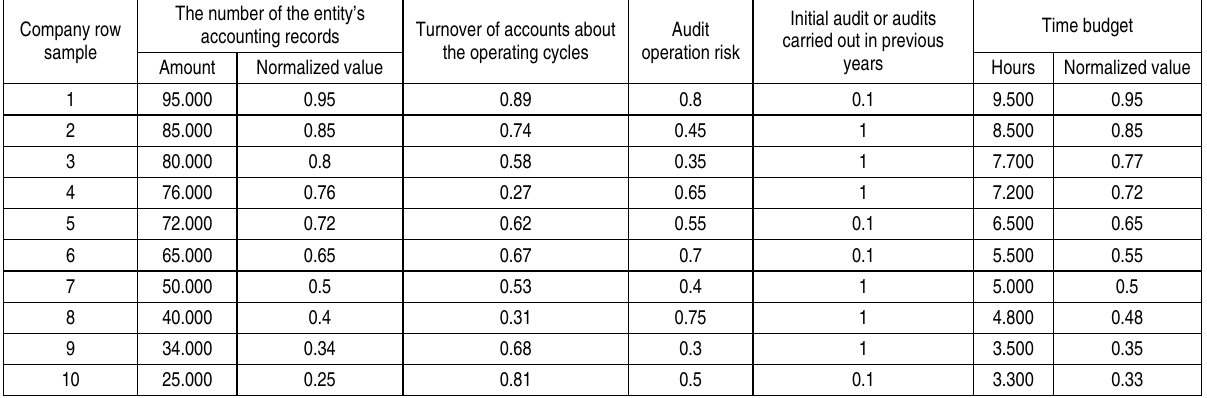
Table 9. Predicted time to perform audit procedures in 10 sample companies